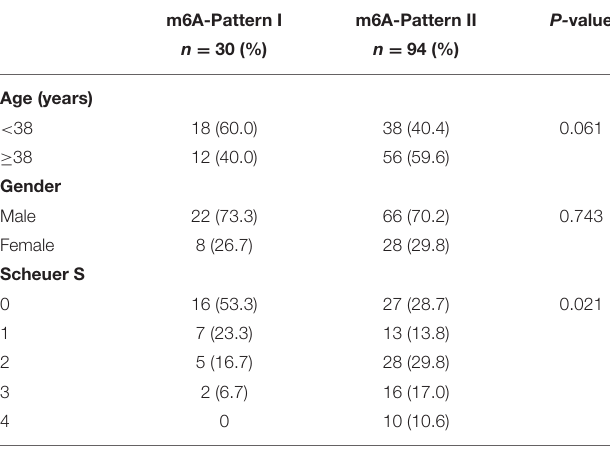
TABLE 1 | Age, gender, and Scheuer score (S) of both N6-methyladenosine